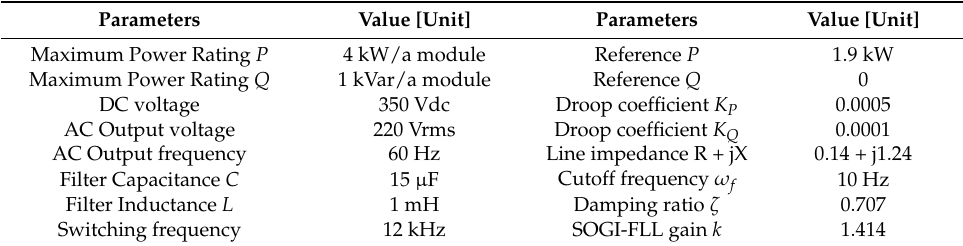
Table 3. Simulation and experimental